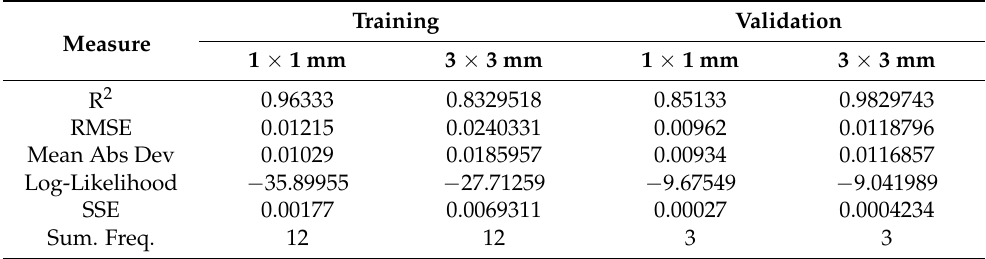
Table 2. Training and validation measures obtained for Y b dependent variable.